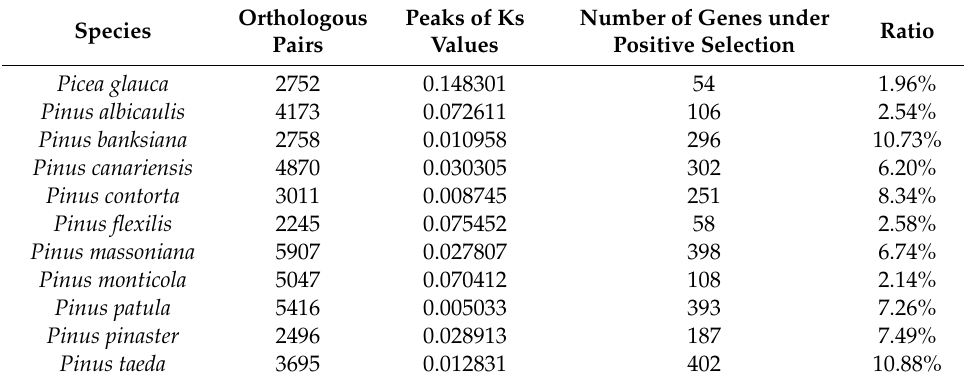
Table 3. The peaks for the Ks value (the synonymous substitutions per site) and the number of orthologous pairs and genes under positive selection between P. elliottii and 11 other conifer